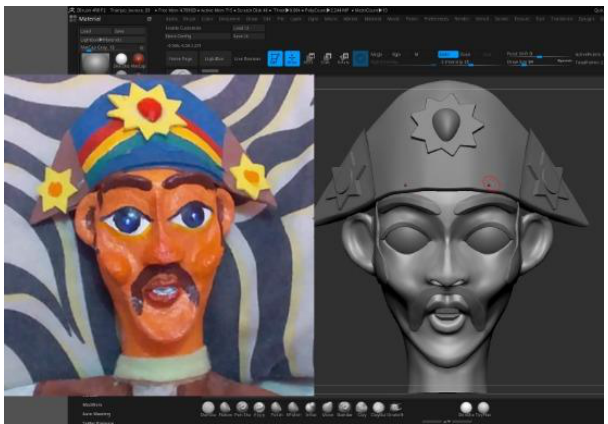
Figure 6. Virtual Puppet 3D modeling by Hugo